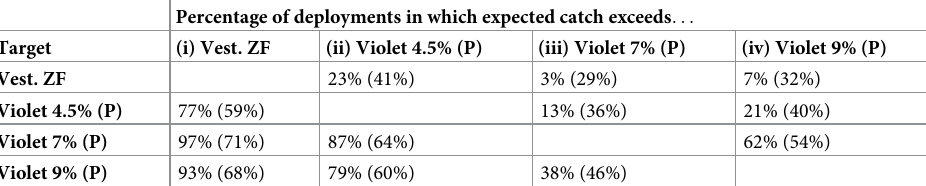
Table shows the percentage of 10,000 simulated catches in which the expected catch ( λ ) of the target in the row heading exceeded that in the column heading for the average catch replicate. Values in brackets indicate the same comparison of catch predictions, but incorporate the additional variability in tsetse catches across replicates estimated by the model.